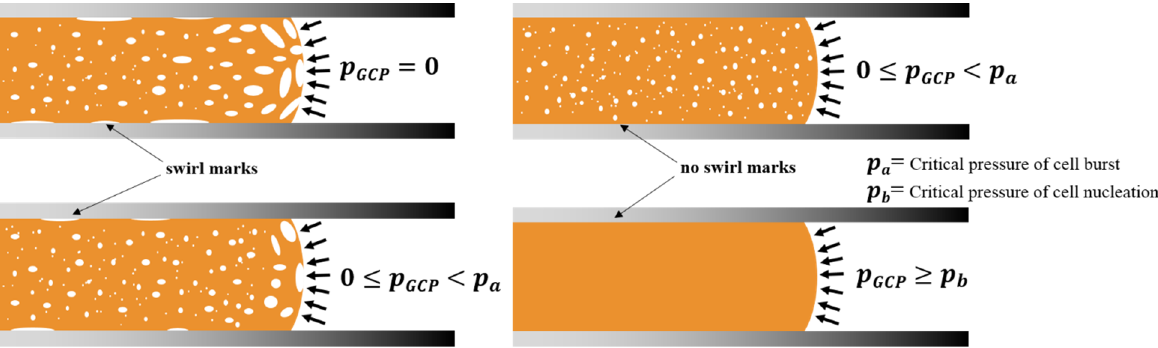
Figure 1. A schematic of gas counter-pressure (GCP) built at the melt front and its effect on the foaming process.